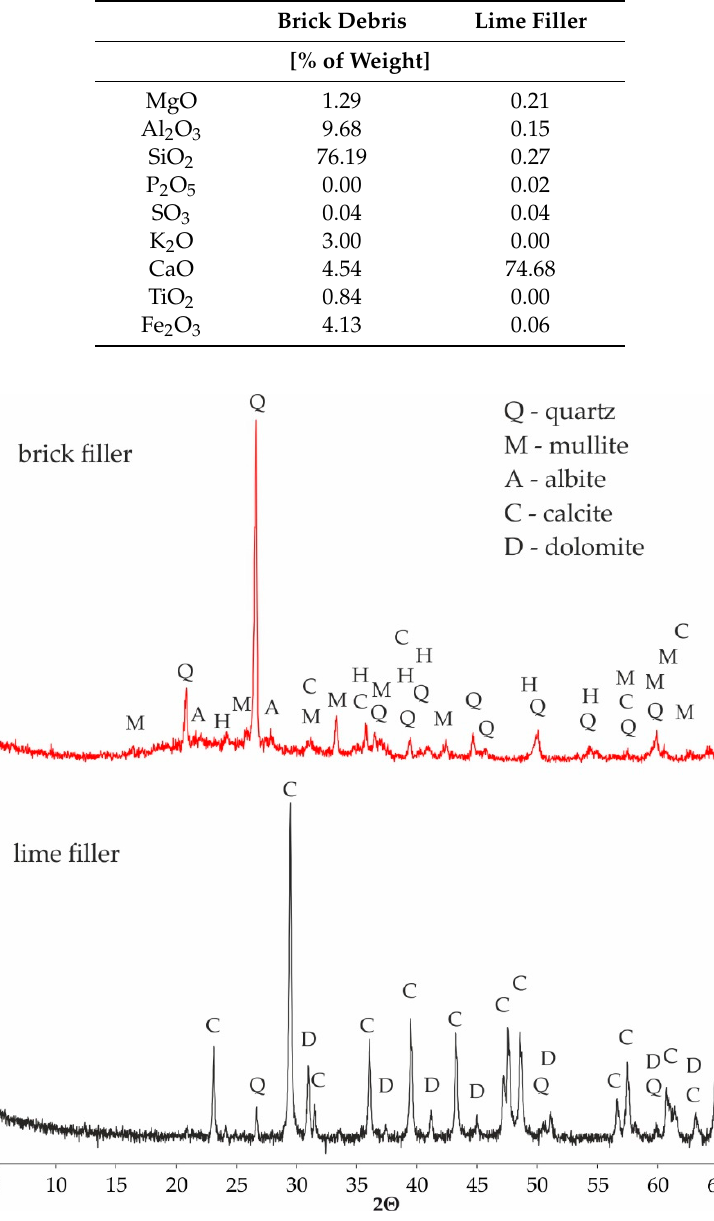
Figure 3. X-ray di ff raction (XRD) patterns of the tested Figure 3. X-ray diffraction (XRD) patterns of the tested fillers.